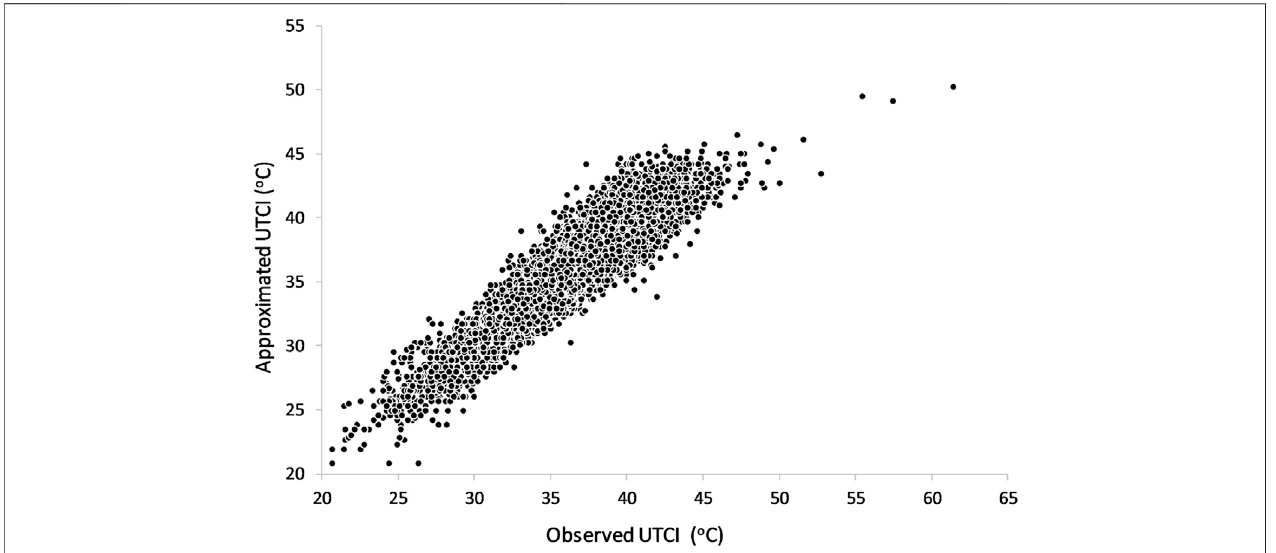
FIGURE 3 | Scatterplot of observed UTCI and approximated